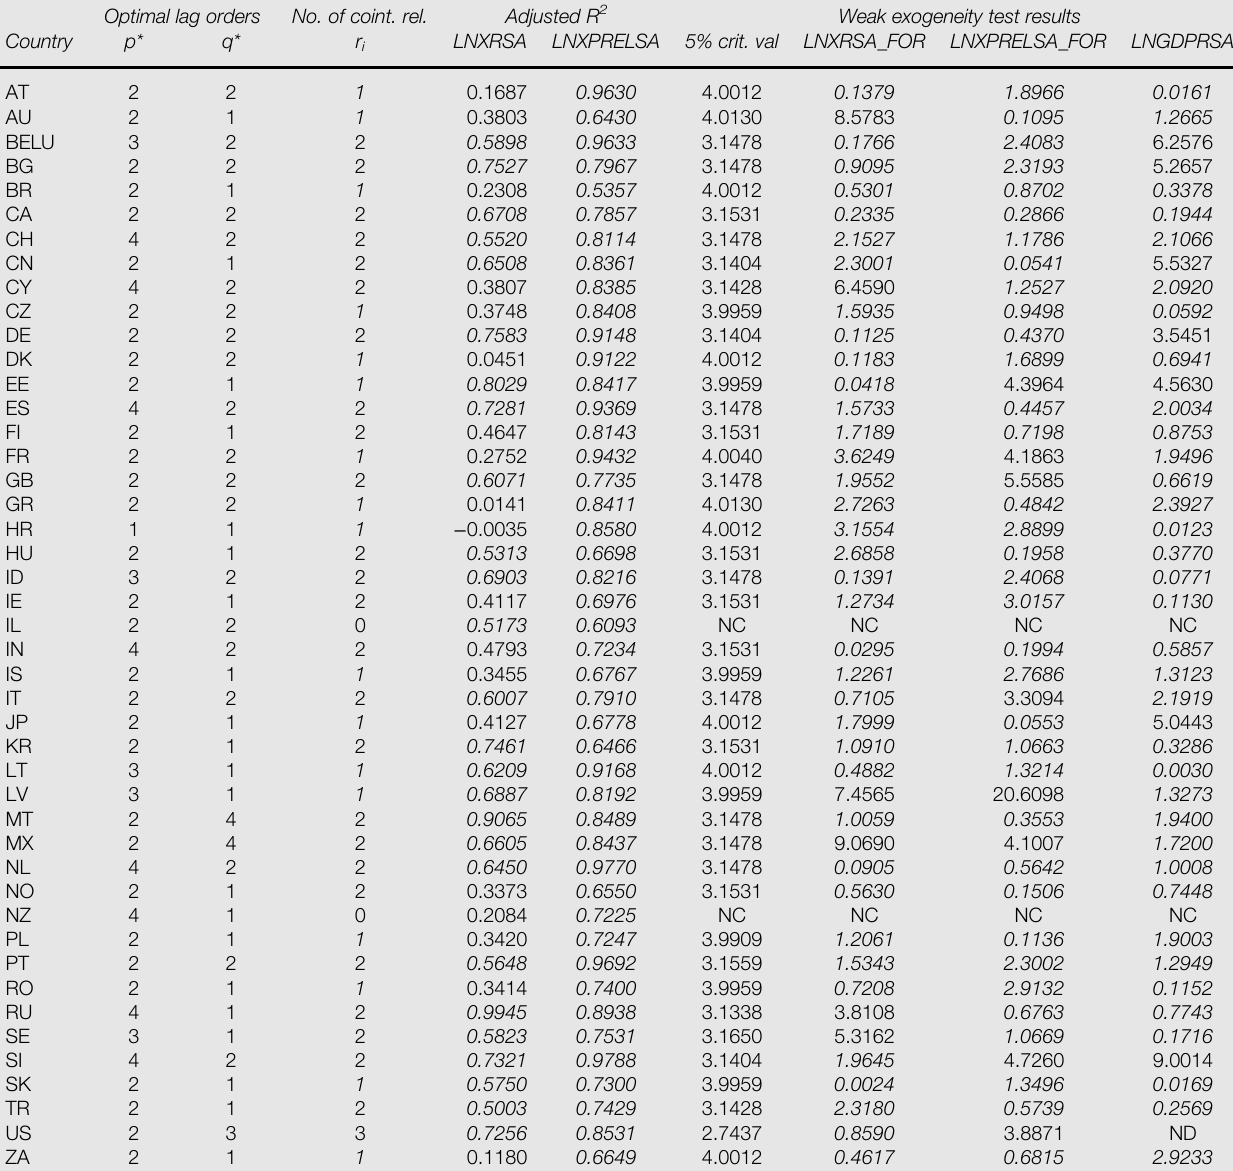
Table I Optimal lag orders, number of cointegration relations, and goodness of fit of the estimated VECMX* models Optimal lag orders No. of coint.